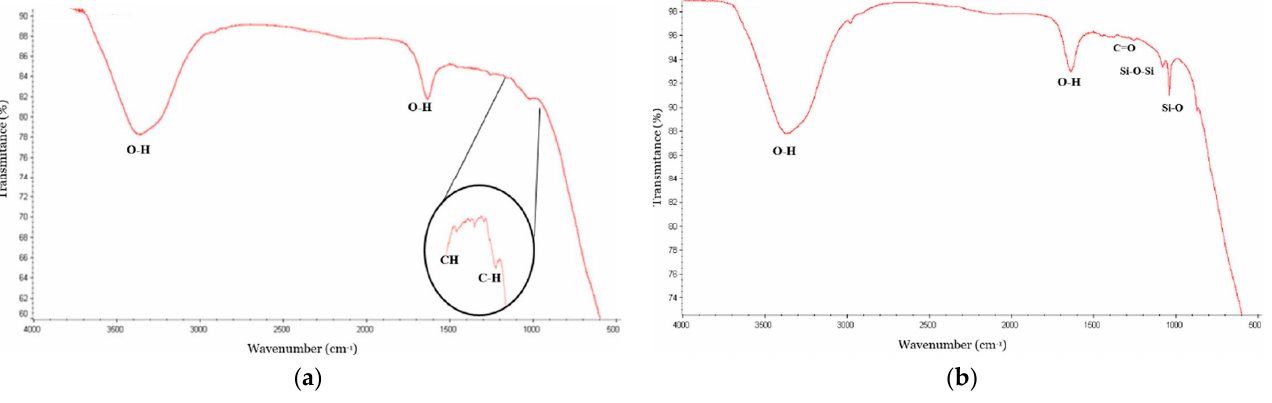
Figure 3. FTIR spectrum of ( a ) the AuNPs coated with PEG, showing the O-H and C-H vibrations bands at 3350 to 3490 cm − 1 and 1630 to 1750 cm − 1 , which correspond to the O-H flexion and stretch- ing vibrations, respectively, and ( b ) the FTIR spectrum of the AuNPs coated with silica, where the bands at 1100, 1300, 800, and 1000 cm − 1 correspond to Si-O-Si and Si-O bond vibrations.